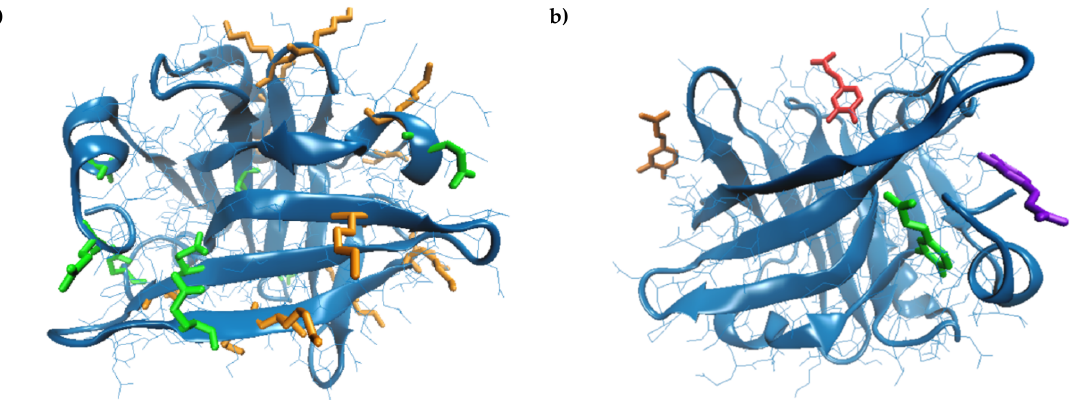
Figure 2. Three-dimensional model of the bovine β-lactoglobulin (4DQ3.pdb) [27] represented in a New Cartoon style. ( a ) Lys and Gln are represented in Licorice in orange and green, respectively. ( b ) Details on ca ff eic acid (CA) binding by β -lactoglobulin ( β -LG) equilibrated at 25 ◦ C—green, 75 ◦ C—blue, 85 ◦ C—ed and 95 ◦ C—orange. The images are prepared using the Visual Molecular Dynamics software